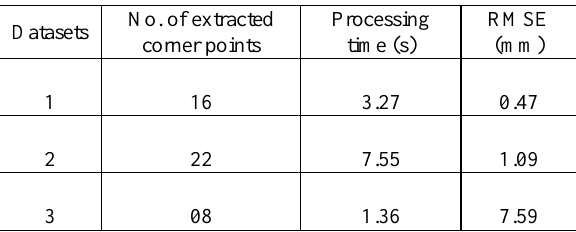
Table 1 . Registration details of